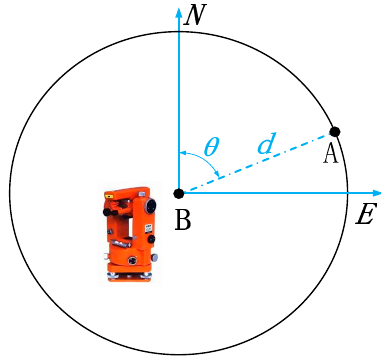
Figure 3. Diagram of aligning to north.